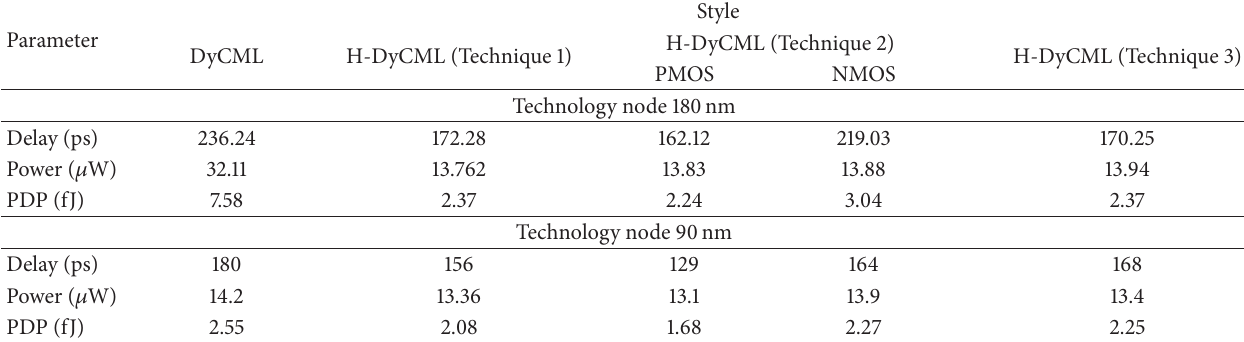
Table 3: Performance comparison of the existing DyCML and the proposed H-DyCML 2-input XOR gate. Parameter